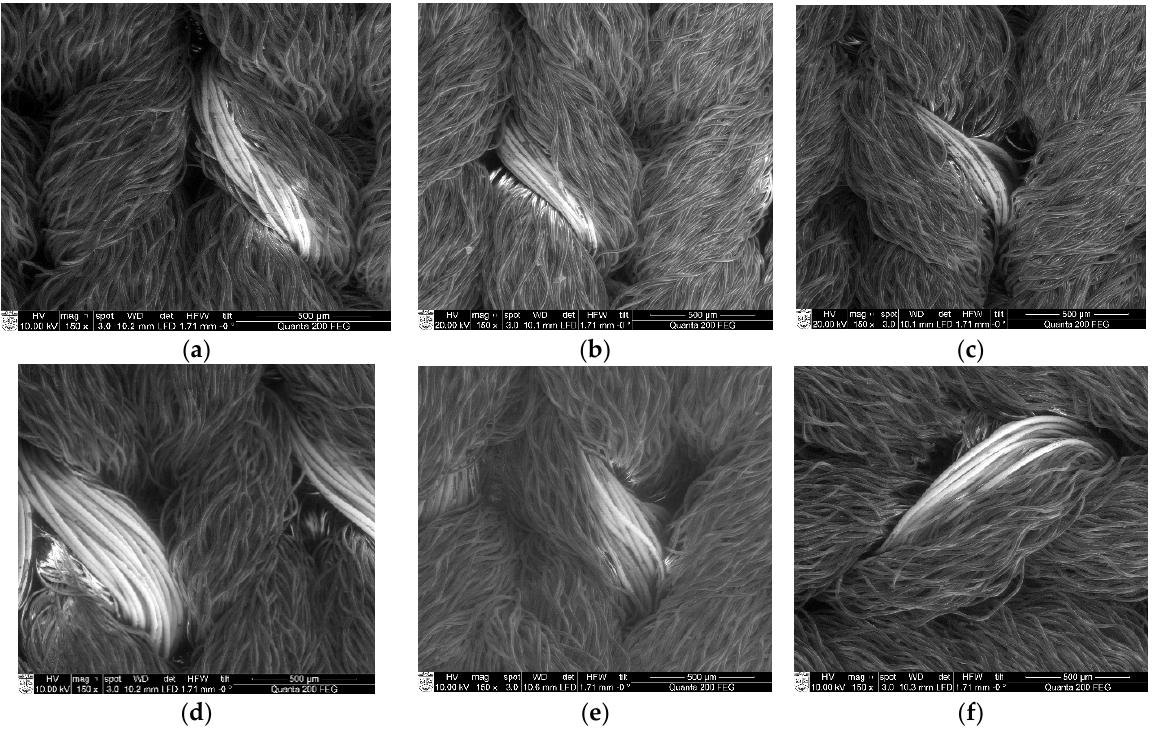
Figure 4. SEM illustrations of metal coated composite structure of ( a ) CF_LY1, ( b ) CF_LY2, ( c ) CF_LY3, ( d ) CF_HY1, ( e ) CF_HY2, and ( f ) CF_HY3 fabrics at 150 × magnification.